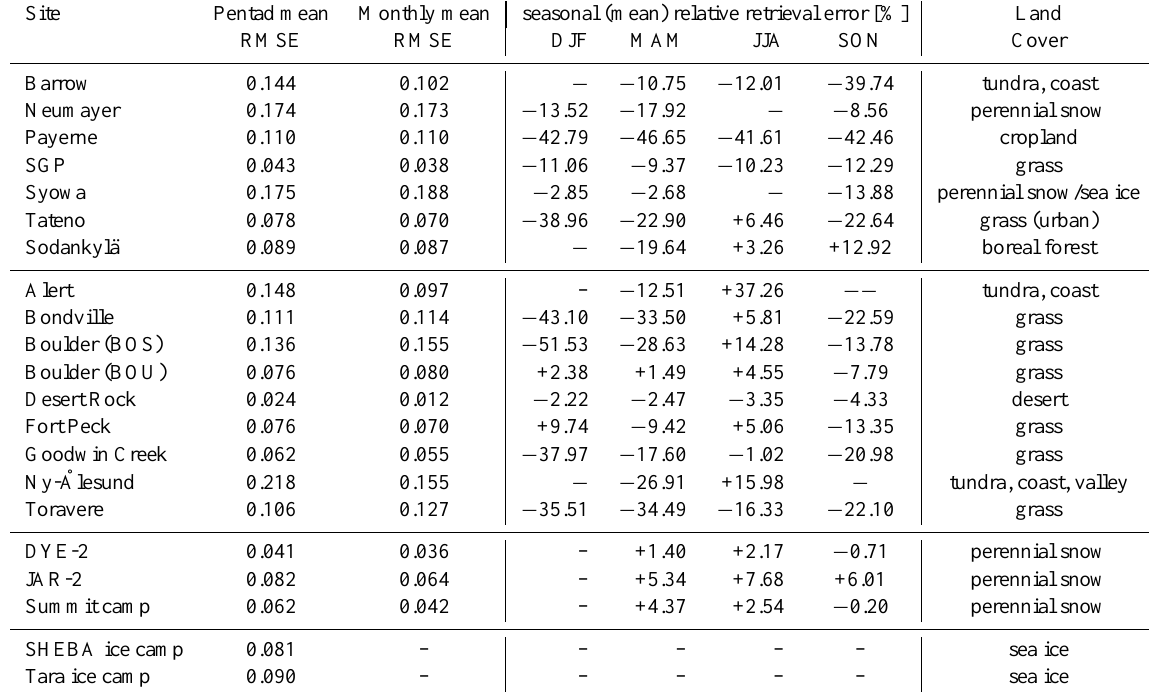
Table 3. Validation results over the full validation period at each site. Pentad and monthly mean RMSE are defined for albedo values in the range of